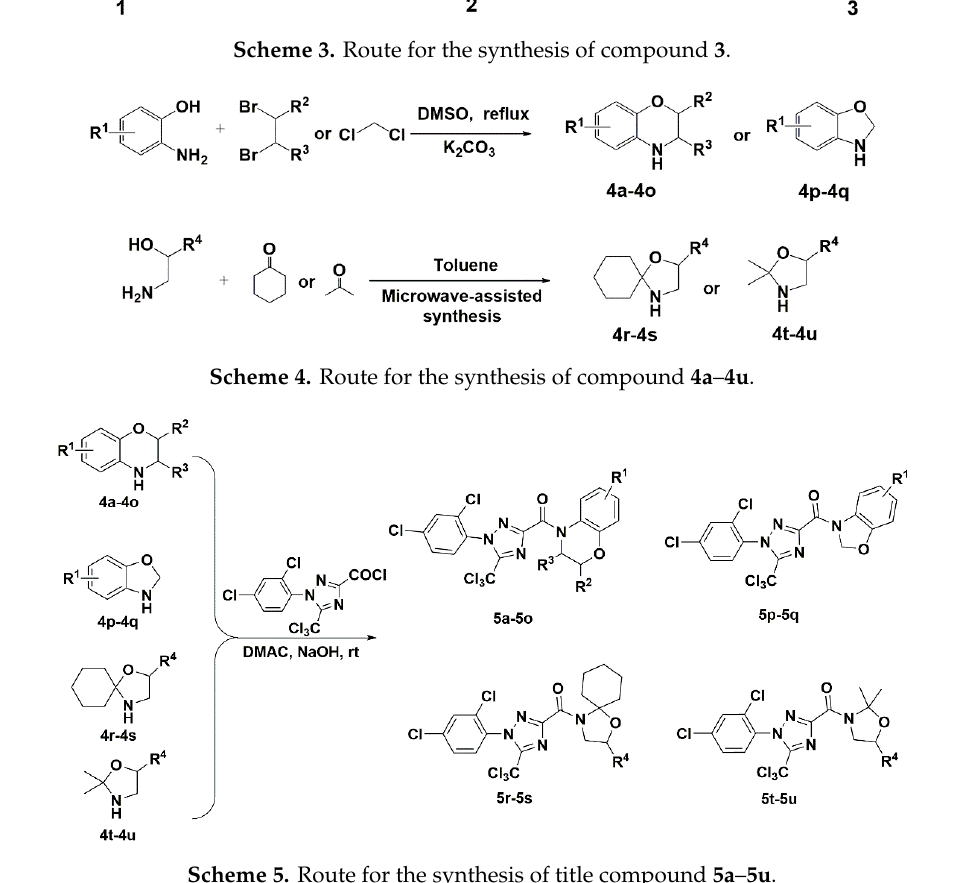
Scheme 5. Route for the synthesis of title compound 5a – 5u .